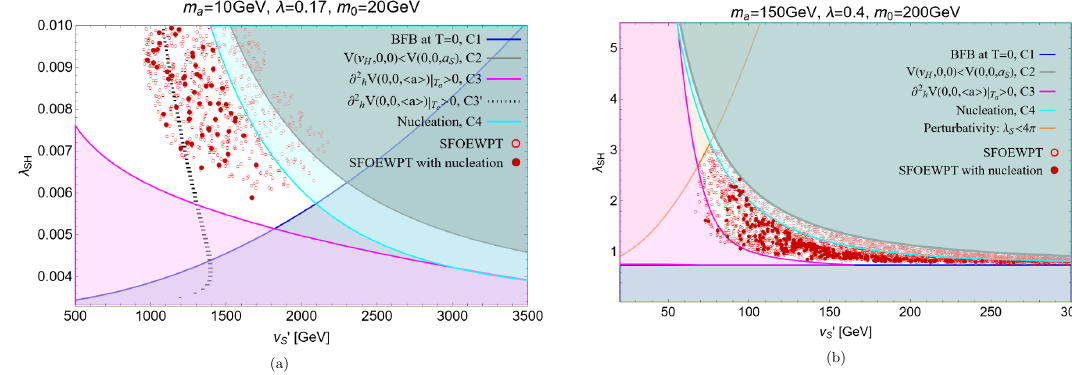
Figure 5. Results of phase transitions on the v 0 − λ SH plane for points satisfying the zero temper- S ature boundary conditions for the same two benchmark scenarios as in figure 3: (a) m = 10 GeV, a m 0 = 20 GeV , λ = 0 . 17 and (b) m a = 150 GeV, m 0 = 200 GeV , λ = 0 . 4 . Points satisfying the nucle- ation and SFOEWPT conditions, S . 140 and h ( T ) /T 1 , are shown as red solid circles, 3 /T EW n n > and points satisfying the condition h ( T ) /T 1 are shown as red open circles. The analytical EW c c > bounds derived in section 3, C1 - C4 are shown by the lines. The shaded regions are excluded by the corresponding conditions. C3’ , the condition derived at T , is shown for m = 10 GeV only, since c a the derivation for T only applies to the case with m 2 . The perturbativity requirement c a < m h / λ S < 4 π is shown for m a = 150 GeV , while the λ S for m a = 10 GeV is always small enough to satisfy this requirement. The lowest y -axis value for λ for these figures is set by eq. SH